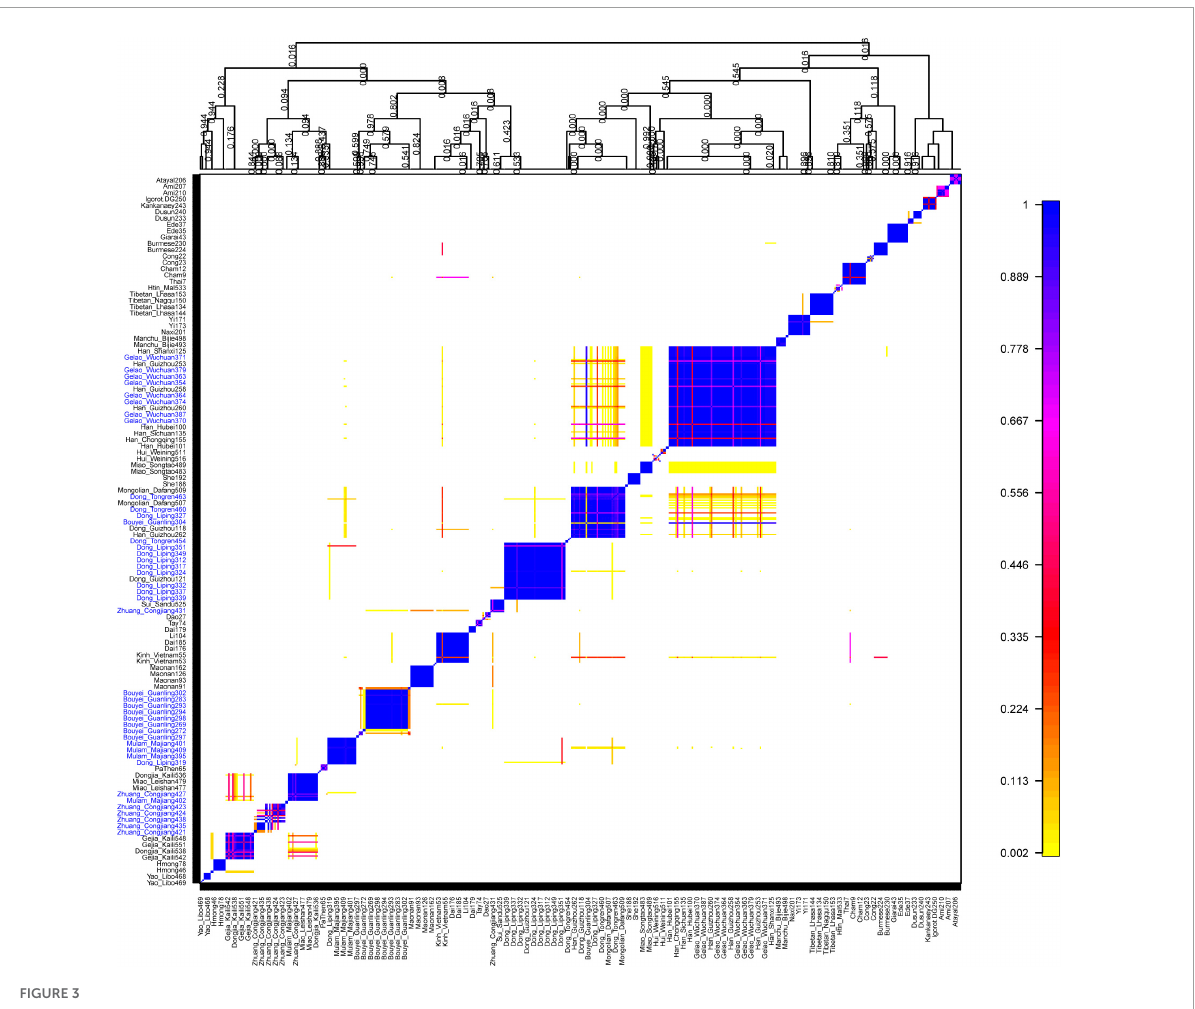
FIGURE3 Fine-scale population structure based on the pairwise coincidence matrix.